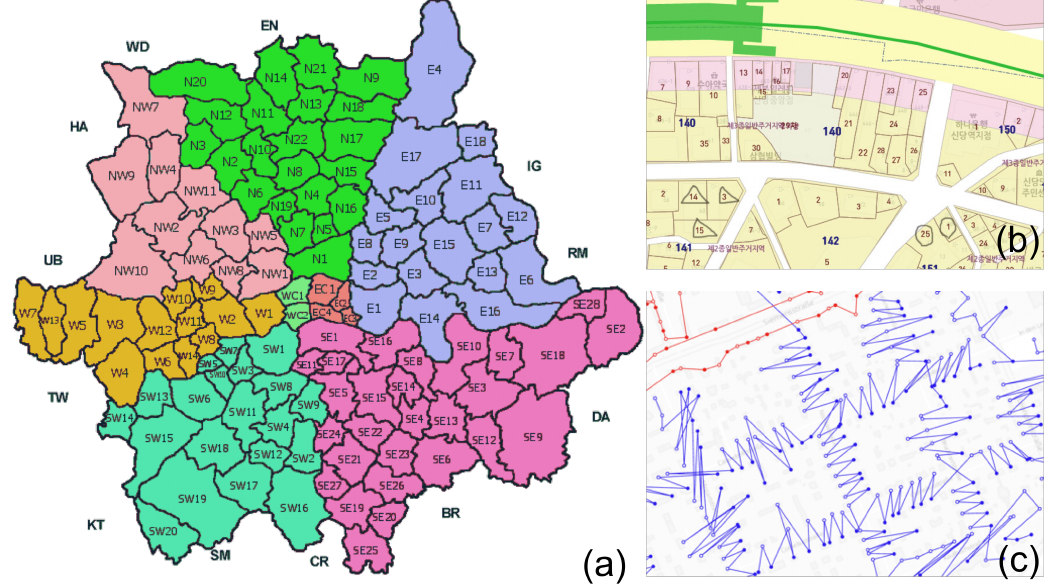
Figure 2. Traditional Addresses. ( a ) The radial regions for London postal codes, where the first letter indicates orientation, and the second letter indicates distance from the city center; ( b ) South Korea lots with sequential numbers; ( c ) Berlin house numbering with zig-zag path to preserve odd parity on the same side of a